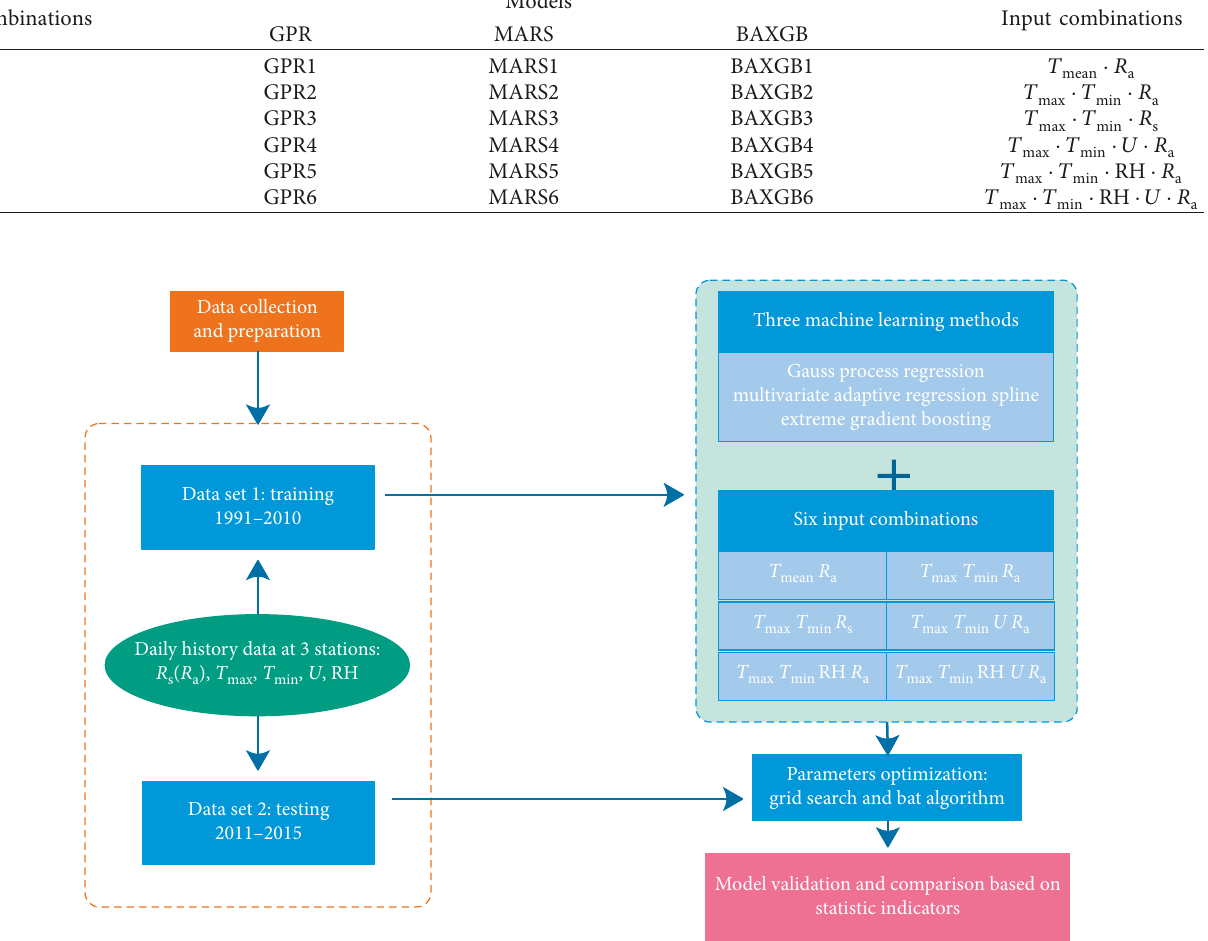
Table 2: Input combinations of different meteorological parameters used in this study. Combinations